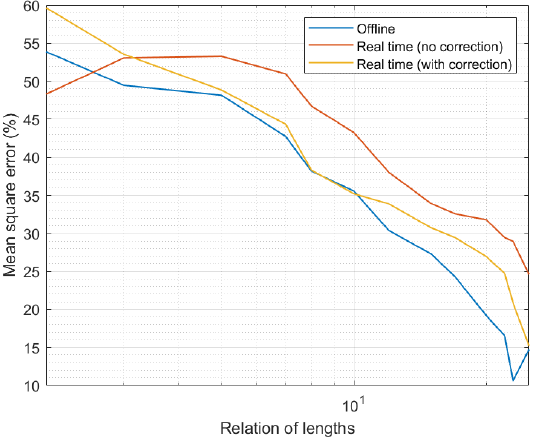
Figure 7. Results of the fourth experiment.